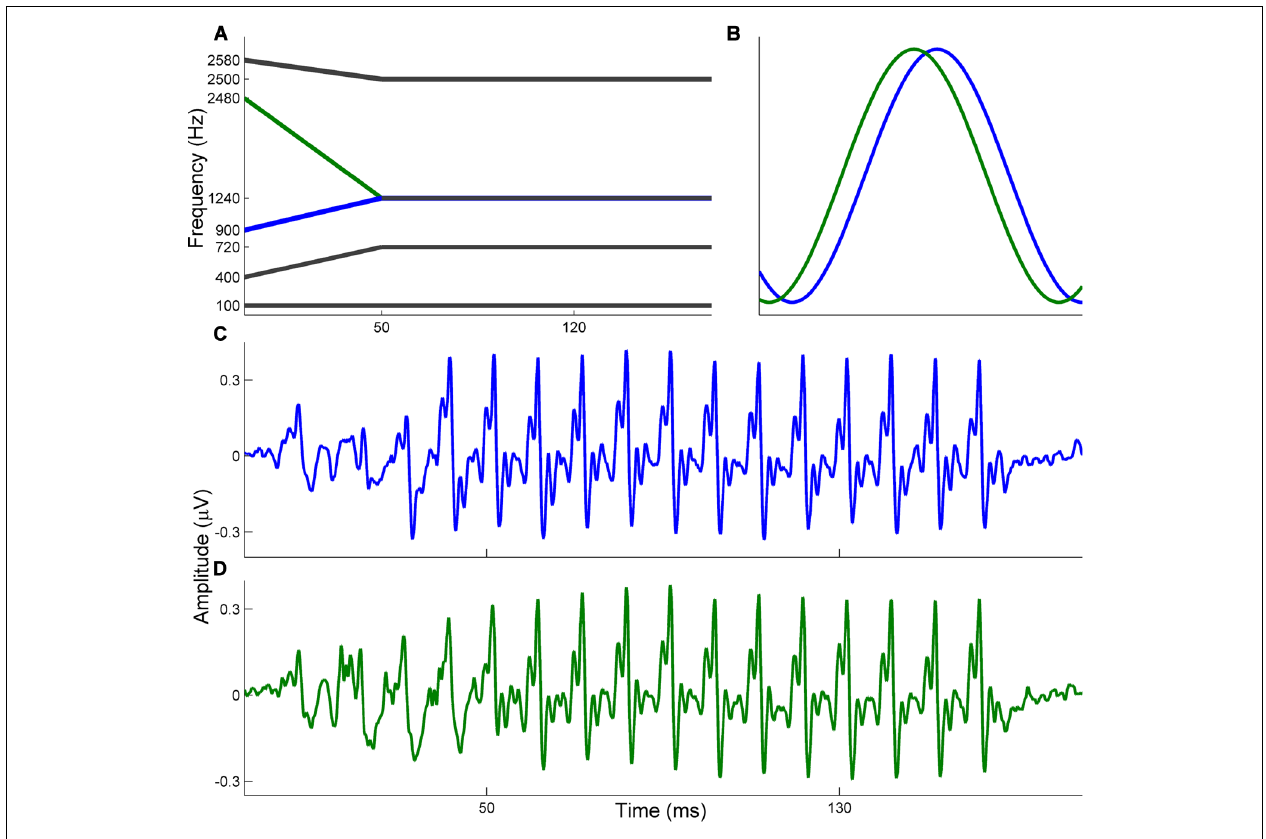
relationship between brainstem responses to the [ba] and [ga]. Since the [ga] (green) has a higher F 2 onset frequency it is expected that brainstem responses to [ga] phase lead those to [ba]. (C,D) Grand average waveforms are displayed for the [ba] (top, blue) and [ga] (bottom,